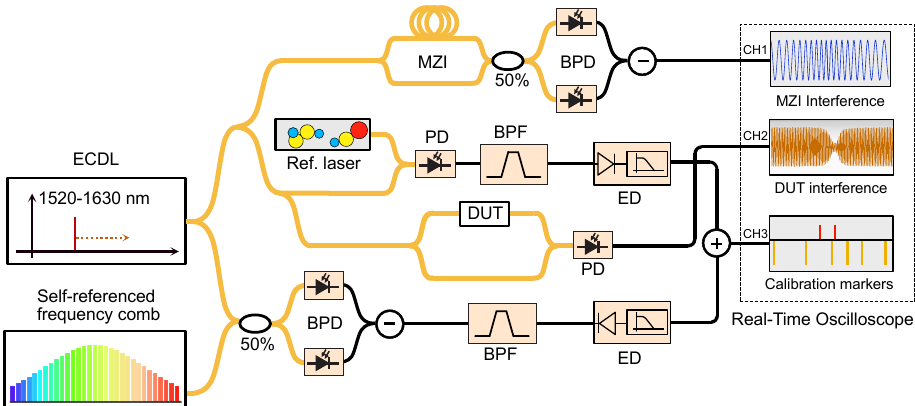
Figure 6. Frequency comb calibrated swept wavelength interferometry. Measurement setup for the acquisition of frequency calibrated SWI/OFDR interference fringe pattern. Frequency calibration is achieved through beat markers provided by fiber selfreferenced frequency comb, a laser locked to a known absorption resonance and the fiber MZI interference pattern. The acquisition of patterns in the boxes of an oscilloscope are from different channels. ECDL: external cavity diode laser; BPD: balanced photodetector; PD: photodetector; BPF: bandpass filter; ED: envelope detector; PD: photodetector